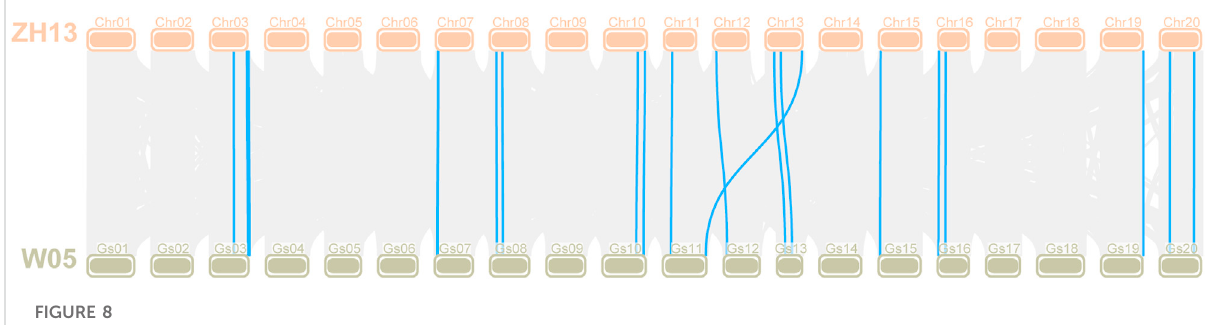
FIGURE 8 Collinearity analysis of the LOX gene between Zhonghuang 13 and G. soja W05 Note: The orange bars at the top marked with Chr01-20 represent chromosomes in Zhonghuang 13, and the green bars labelled Gs01-20 at the bottom represent the wild soybean ( G. soja W05) chromosomes. Orthologous gene pairs of genes in the two varieties are linked by blue highlighted lines.